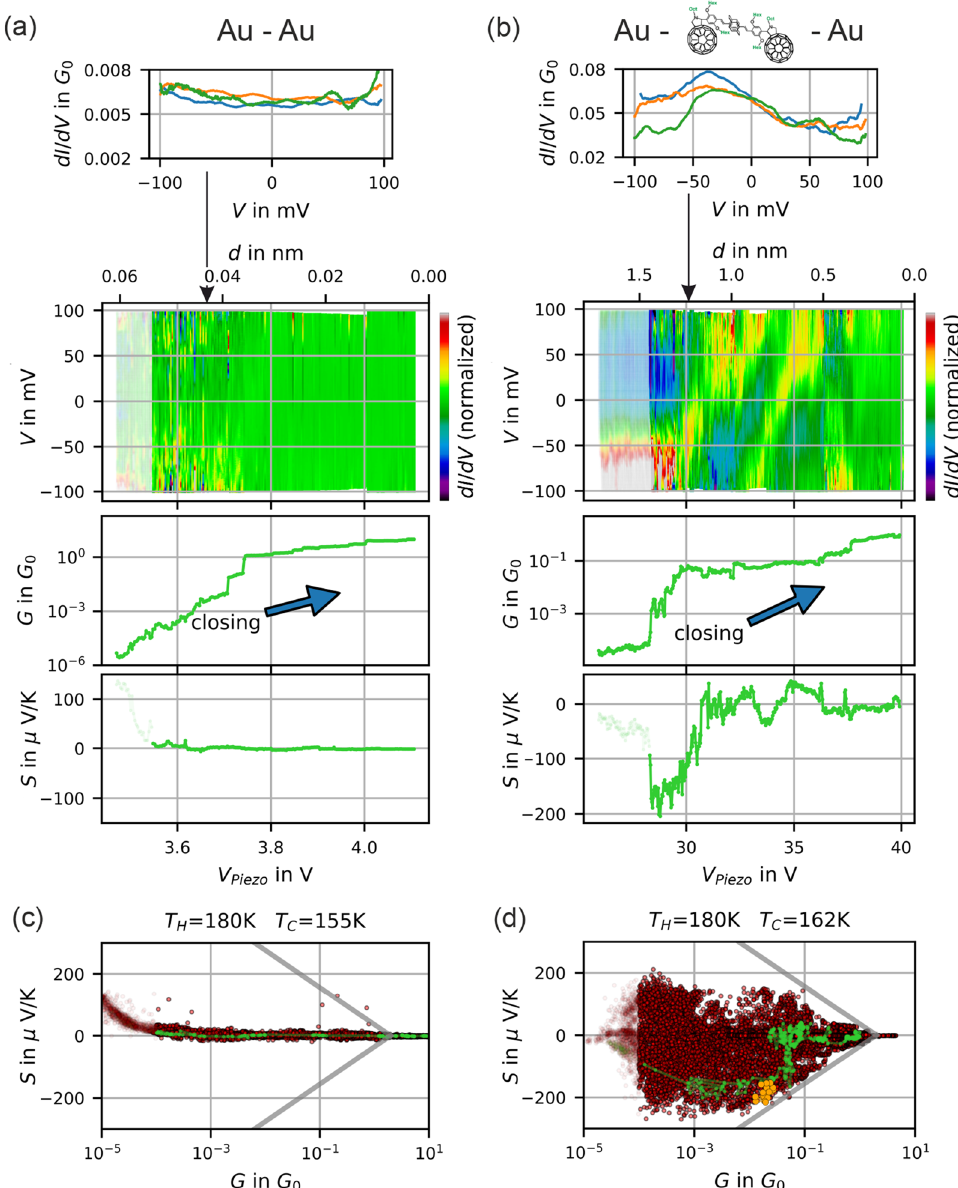
S measured during mechanical variation of the junction’s distance (here: closing). ( a ) A bare gold-gold junction and ( b ) a junction with fullerene end-capped molecules 16,17 (SI) applied to the electrodes. ( c , d ) Show correlations of S and G using the data of the whole ensembles enclosing 21 (27) opening and closing cycles with a total of 14431 (25519) dI / dV and S measurements. Green dots correspond to the data in ( a , b ). Orange dots mark a sub-ensemble with high conversion efficiency. Gray lines are eye guides which separate G − S pairs from exclusion